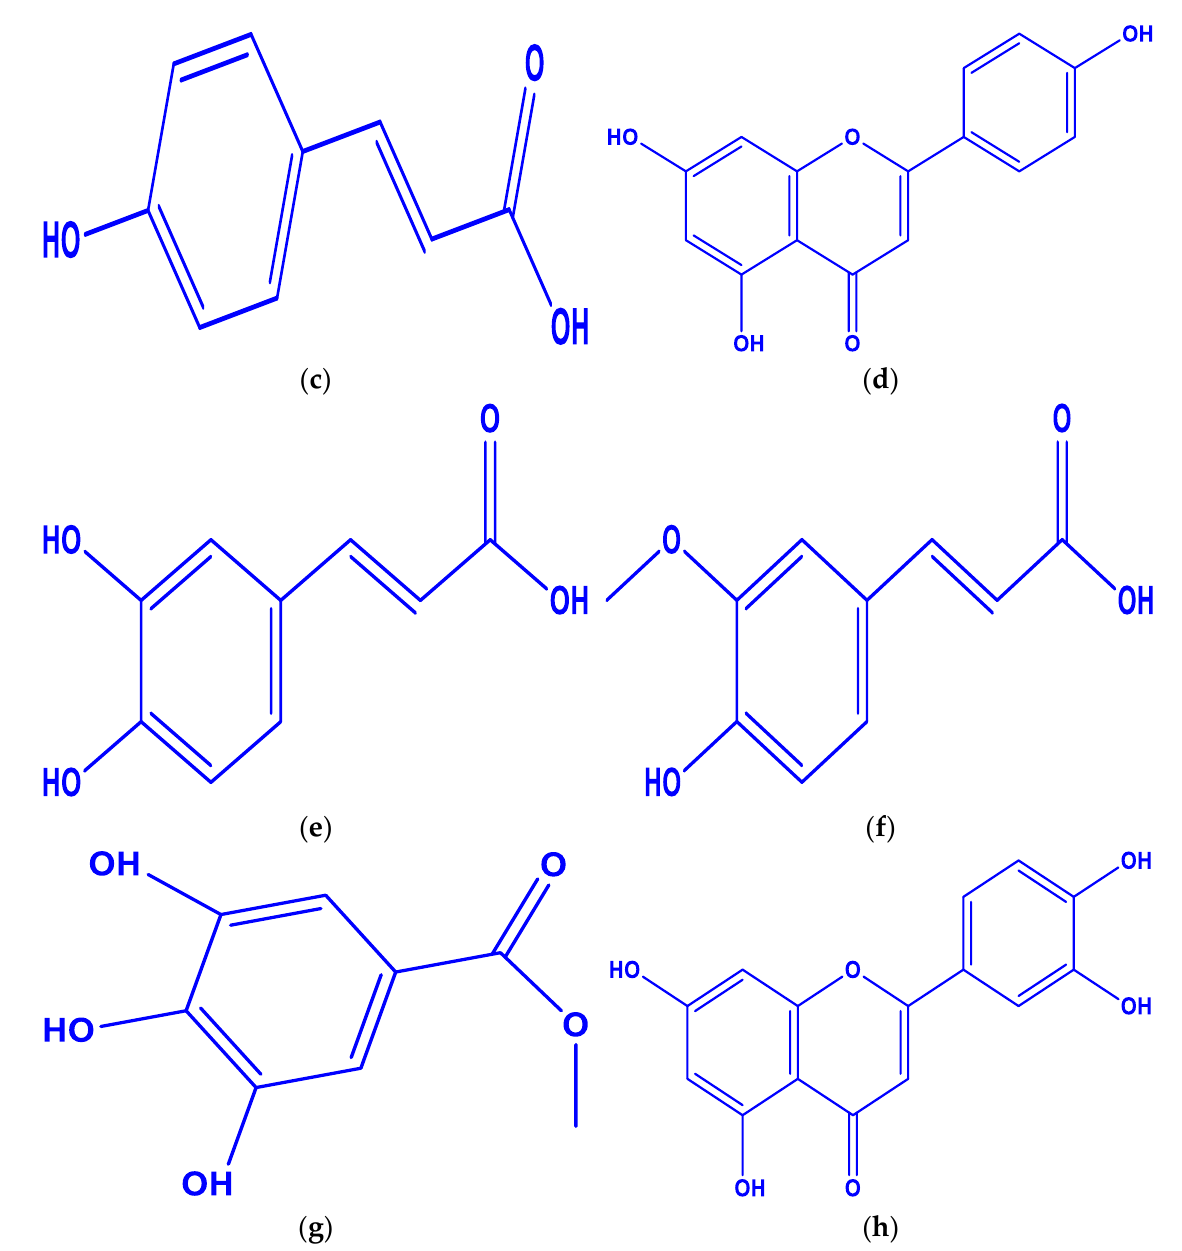
Figure 2. Molecular structure of phenolic compounds identified in W. adpressa extract by use of HPLC. Galic acid ( a ); Rutin hydrate ( b ); p-Coumaric acid ( c ); Apigenin ( d ); Cefeic acid ( e ); Ferulic acid ( f ); Methyl gallate ( g ); Luteolin ( h ).